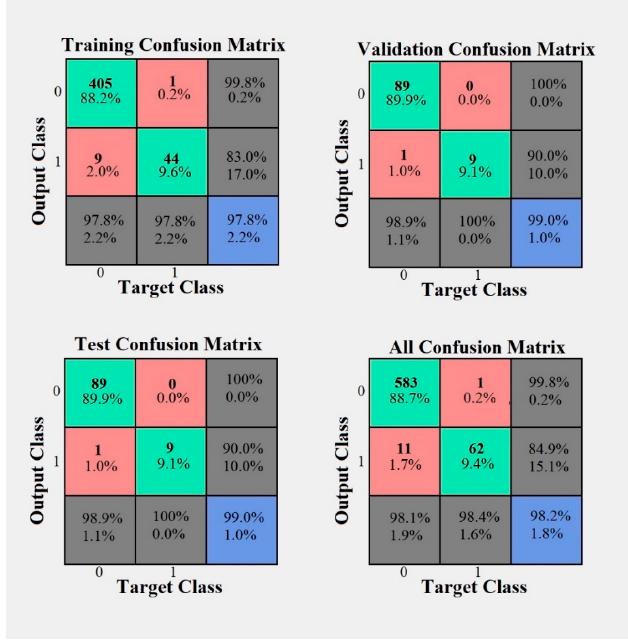
Figure 9. Error matrix of a network using polynomial coefficients with the degree N = 2.